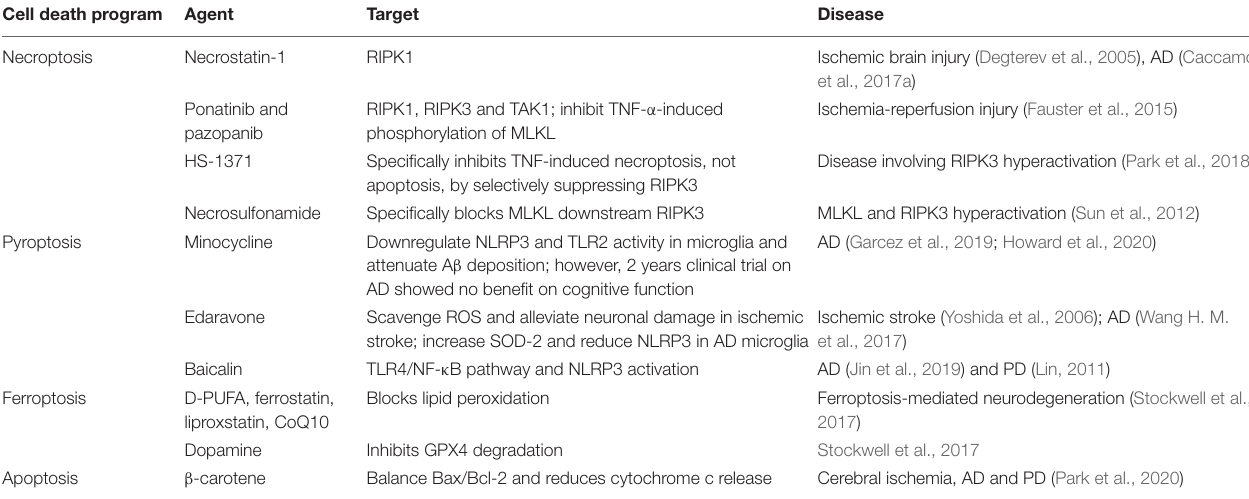
TABLE 2 | List of current and prospective inhibitors of different programmed cell